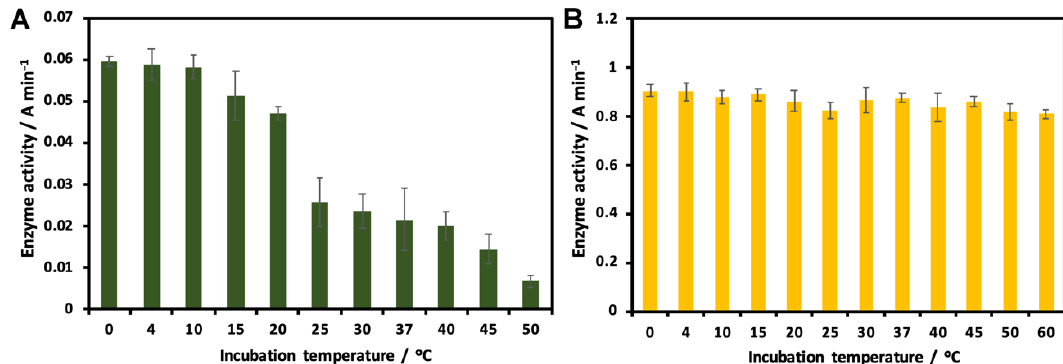
Figure 5. Effect of temperature on ( A ) Slt35 and ( B ) lysozyme activity. For Slt35, the 7 μ M enzyme and 0.6 mg mL − 1 cell suspension were used in 25 mM Tris-maleate (pH 5.8) containing 10 mM CaCl 2 . For the lysozyme, the 0.1 μ M enzyme and 0.6 mg mL − 1 cell suspension were used in 25 mM Tris-maleate (pH 6.0) containing 100 mM KCl. The enzyme was incubated for 10 min at the temperatures indicated before being added to the substrate. Activity was monitored at 37 °C.